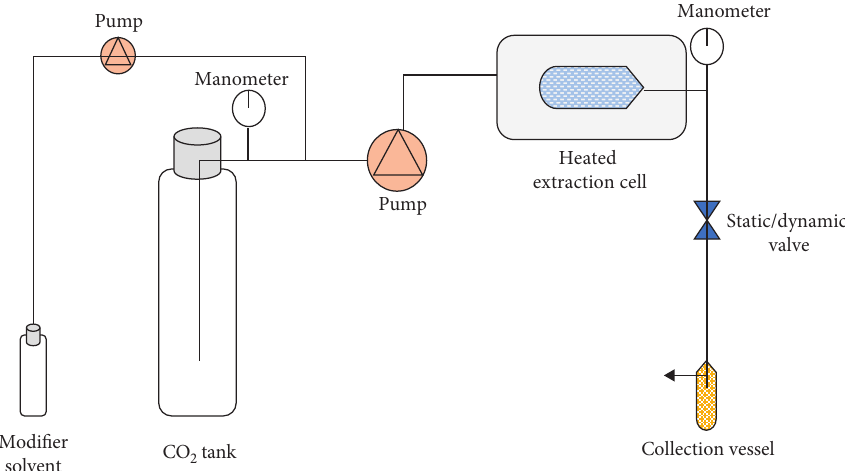
Figure 7: Scheme of supercritical fluid